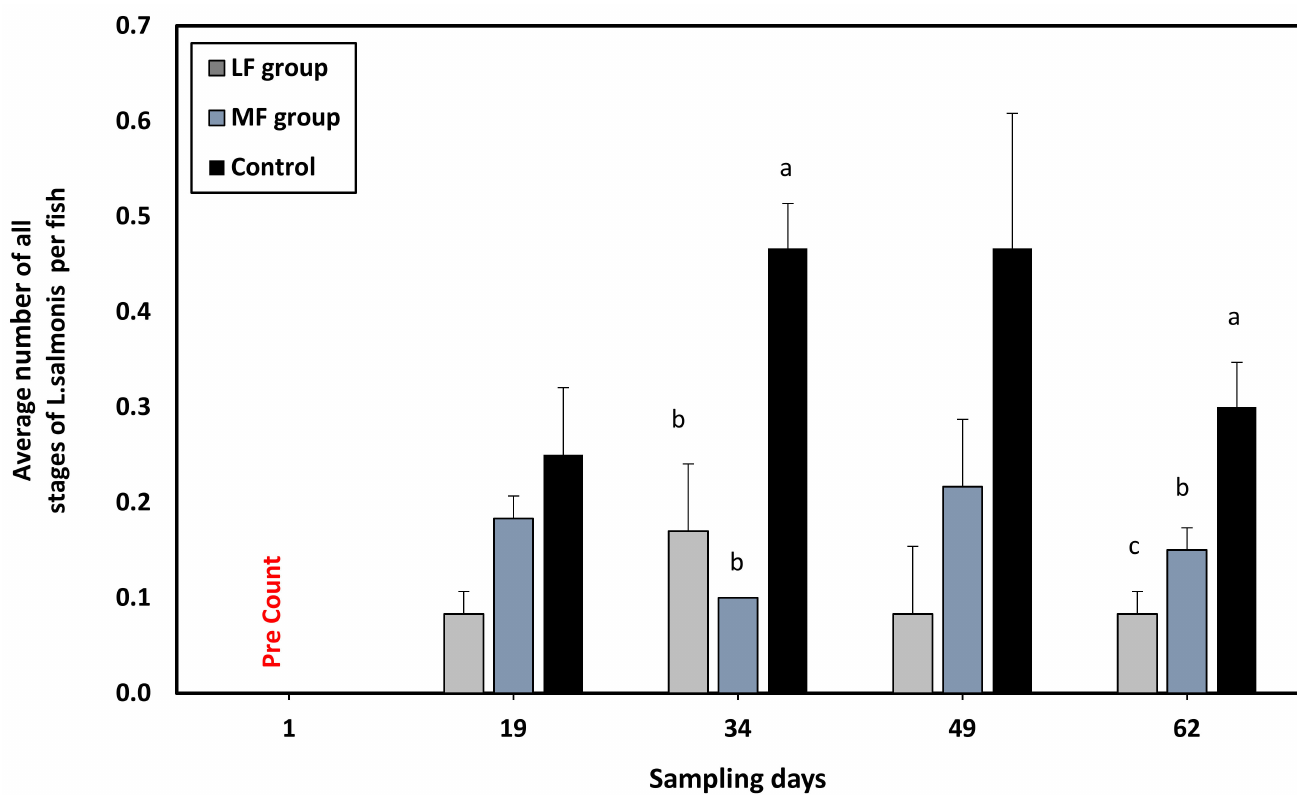
Figure 2. Average of all stages (chalimus, pre-adult, adult male and female) of L. salmonis per fish recorded for Atlantic salmon in sea pens with lumpfish start-fed with either marine dry feed (MF) or combination of dry and live feed (LF). The control group contained salmon without lumpfish present. Values are presented as means ± S.D. Mean values that do not share a letter are significantly different according to ANOVA and SNK post hoc test. Figure modified from